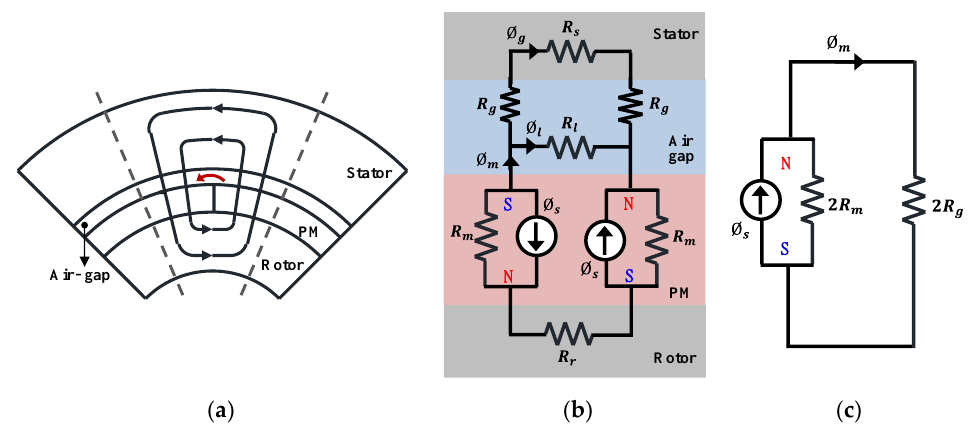
Figure 6. Fundamental model and magnetic circuit: ( a ) Fundamental motor structure, ( b ) Magnetic circuit model, and ( c ) Simplified magnetic circuit.